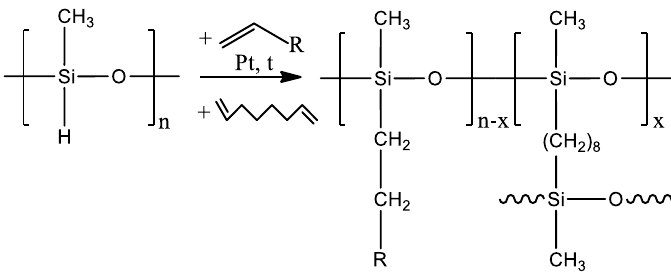
Figure 1. Reaction scheme for the production of polymethylsiloxanes with substituted side-chain.